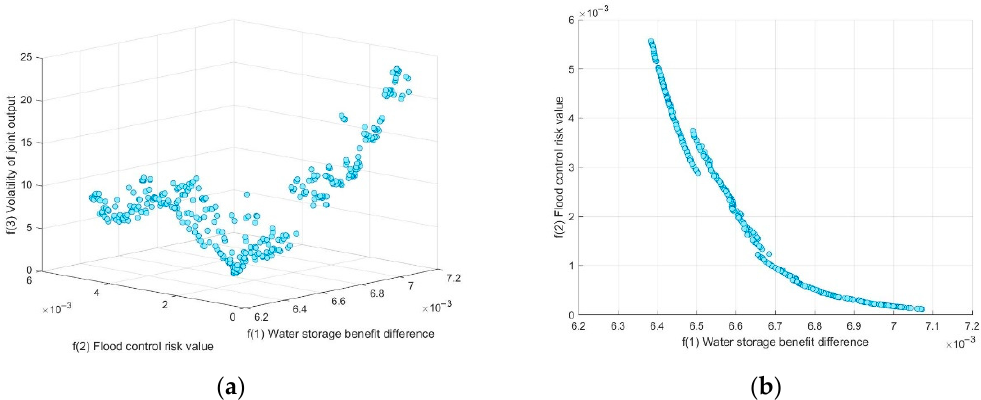
Figure 10. Pareto frontier for multi-objective hedging. ( a ) Pareto frontier with three goals for hedging; ( b ) Pareto frontier of Goal 1 and Goal 2.